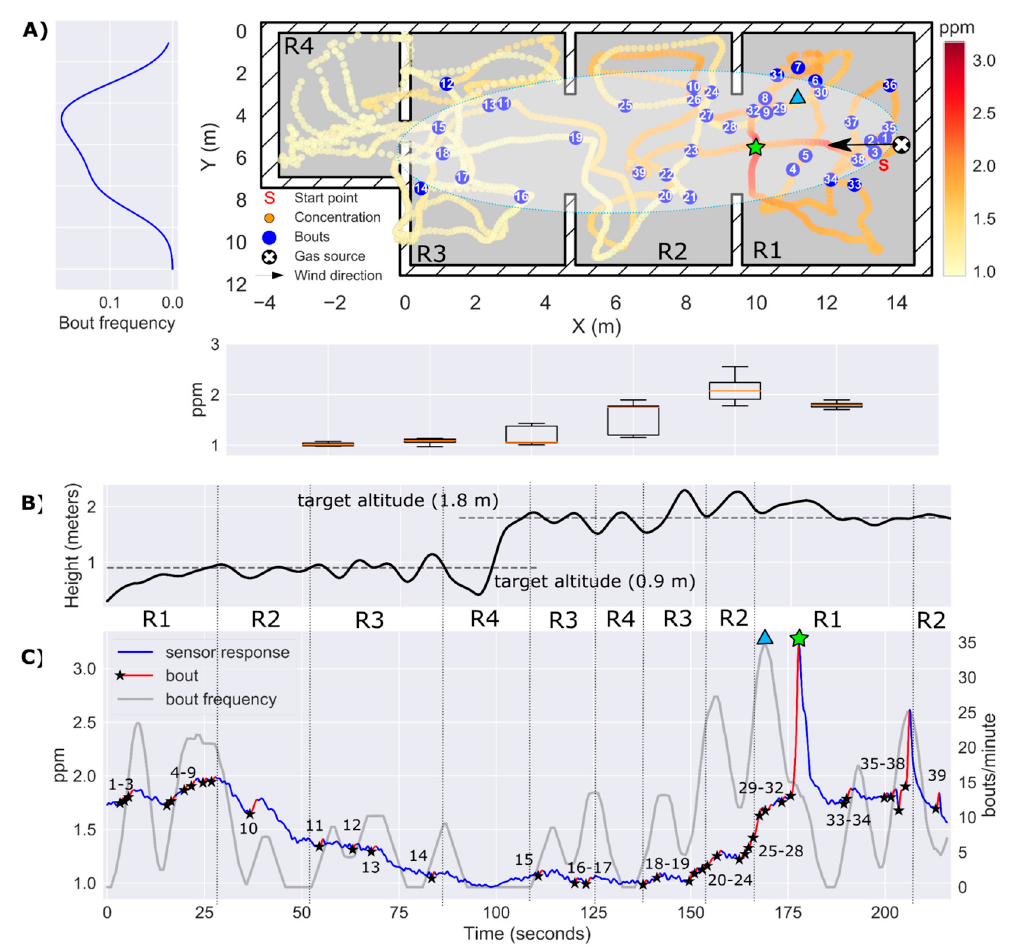
Figure 18. Results of Experiment 2. ( A ) 2D map of the instantaneous concentration (ppm), with odor hits represented by blue circles ( b thr = 0.04 ppm/s). A hand-drawn ellipse outlines the approximate plume shape based on the location of bouts. The average bout frequency along the y-axis is shown in the panel on the left. The box plots below the map represents the instantaneous concentration along the x-axis; ( B ) Drone trajectory in the z-axis. ( C ) Temporal evolution of the instantaneous